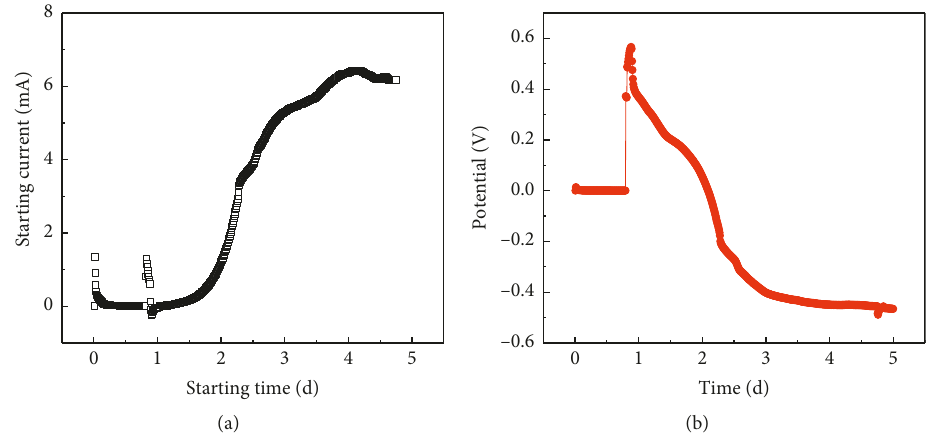
Figure 3: Starting current and anode potential versus